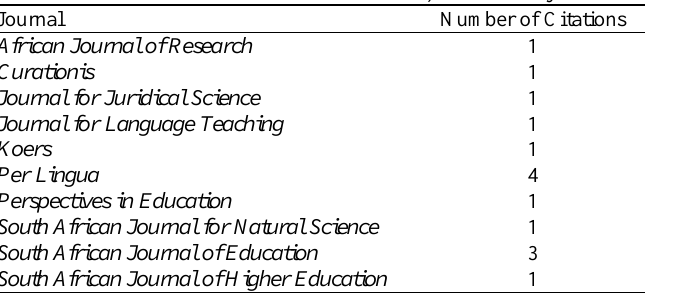
Table 7 South African journals in which citations can be found from doctoral research completed in fields of education in South Africa in 2008; Citations by authors other than the doctoral student